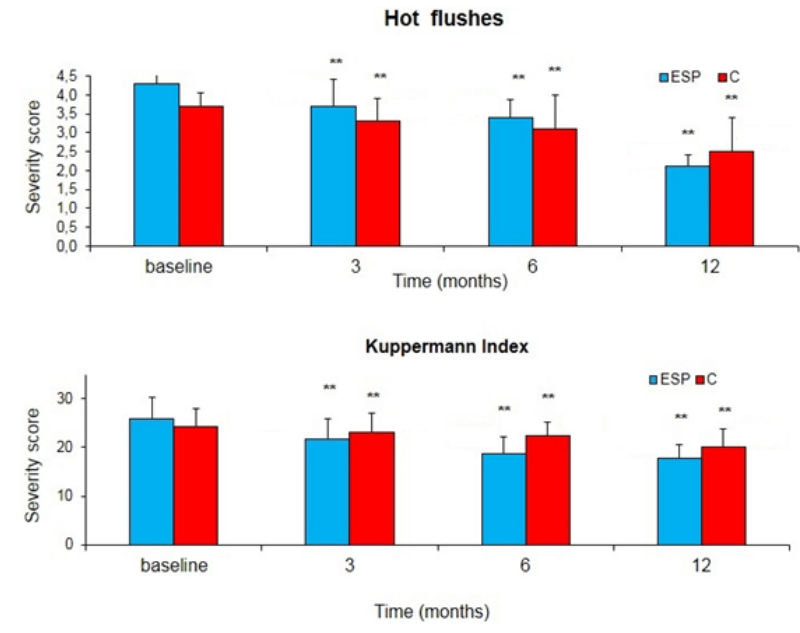
Figure 1. Changes in the severity score of hot flashes and the Kuppermann index during the treatment with soy isoflavones + lactobacilli + magnolia + agnus castus (ESP) or isoflavones alone (C). Data is expressed as mean ± Standard Error (SE). ** p < 0.01 vs. baseline.